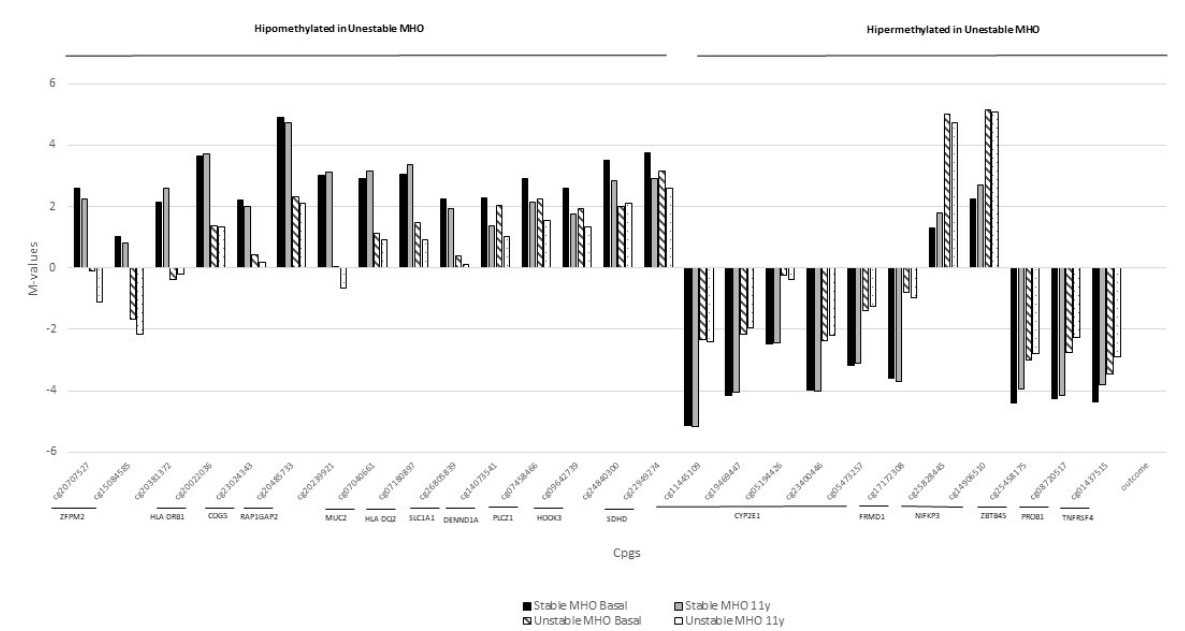
Figure 2. Methylation levels of 26 significantly differentially methylated CpG sites identified in the double PCA selection at baseline and 11-year